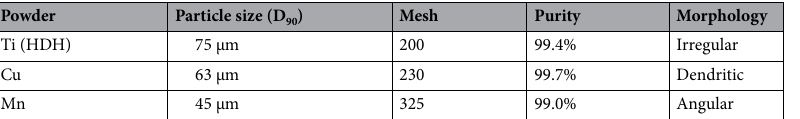
Table 1. Characteristics of the starting powders for the production of the β eutectoid bearing functionalised Ti